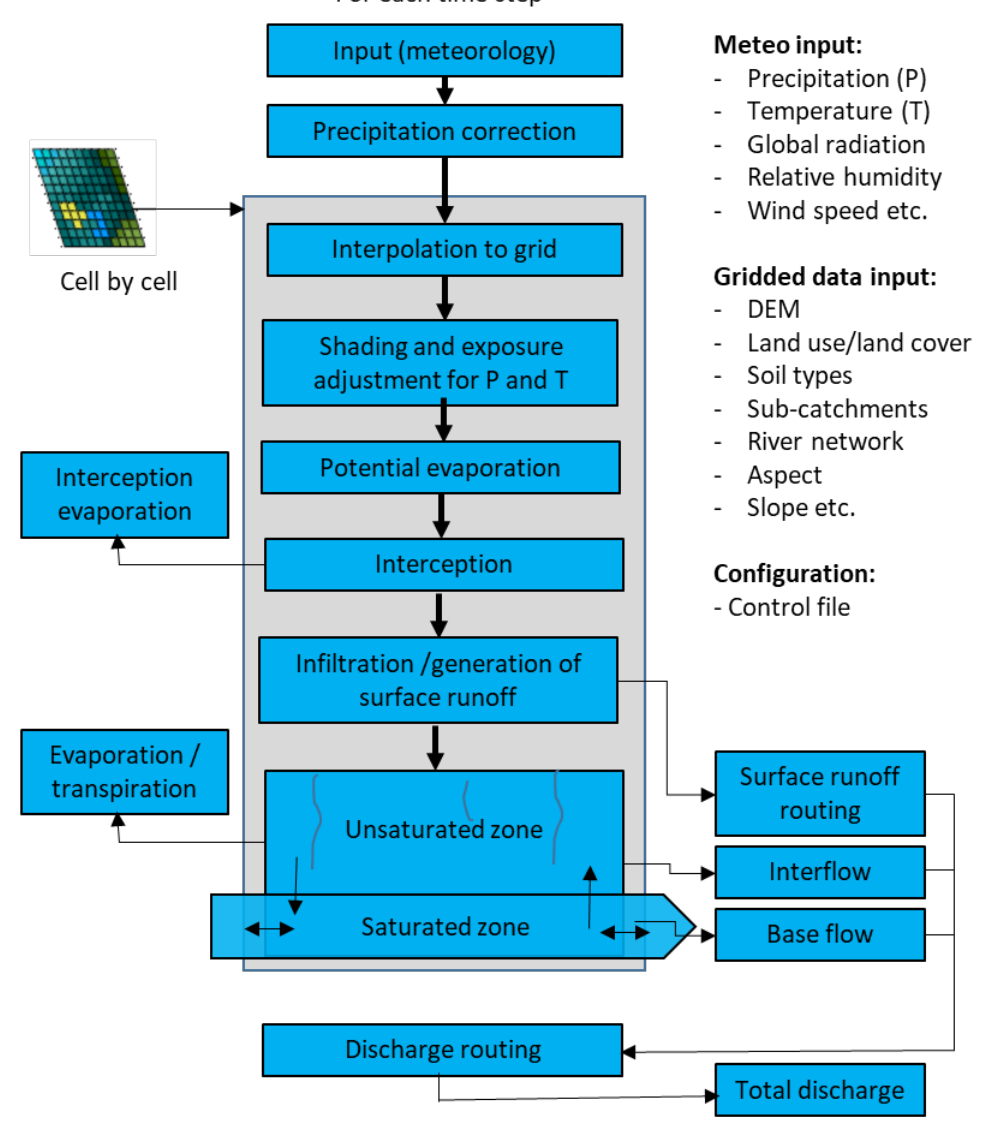
Figure 3. Schematic representation of WaSiM with the implemented modules